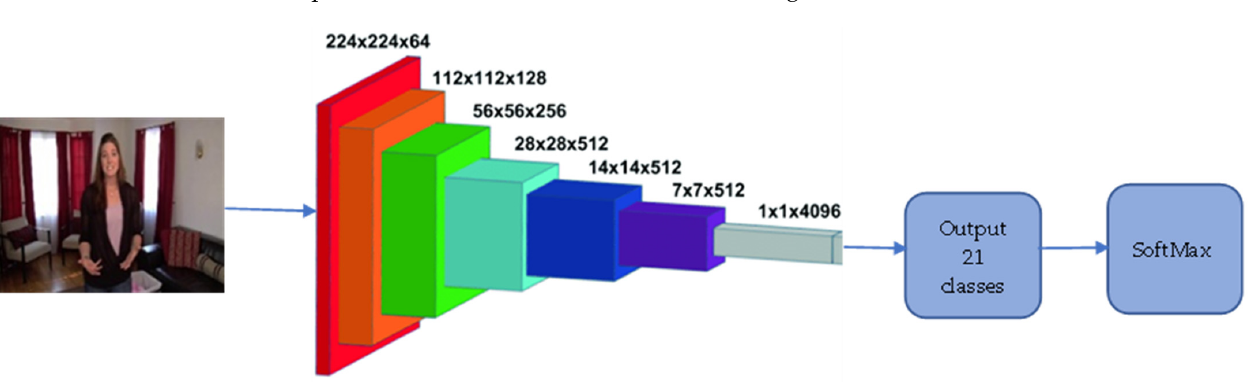
Figure 4. VGG16 Architecture for Human Posture Image Classification. Block